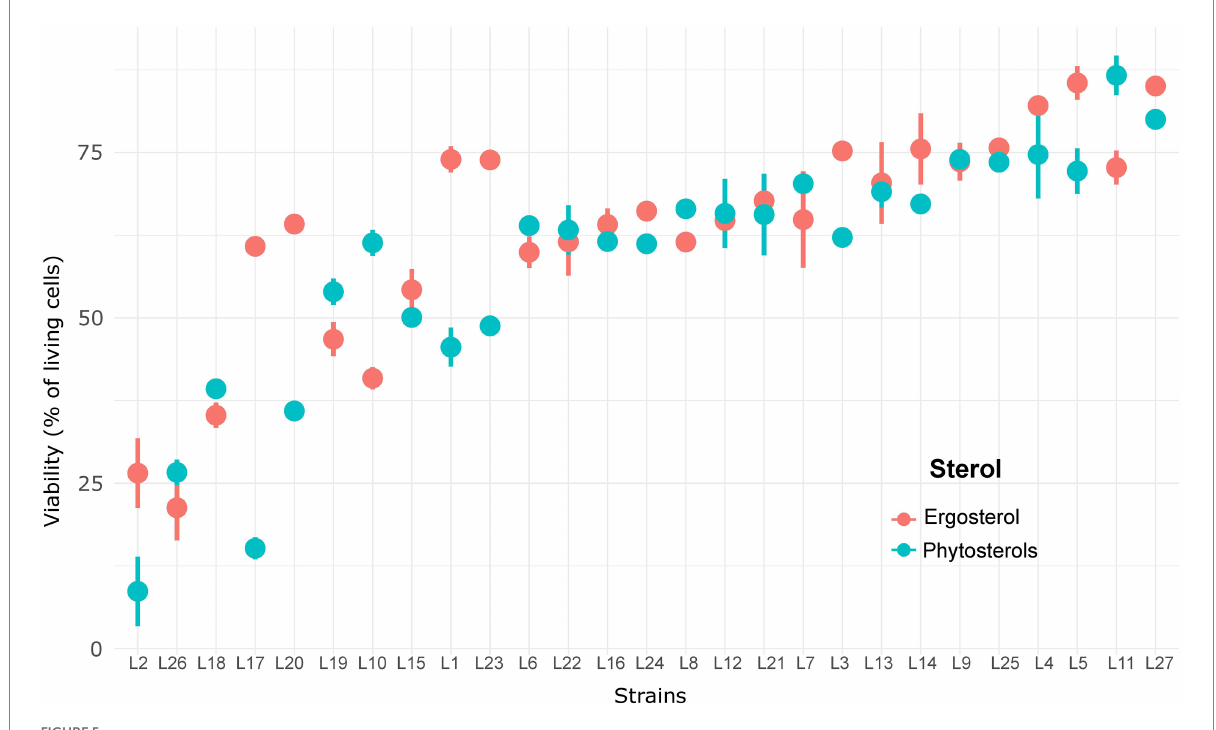
FIGURE 5 Viability of 27 Saccharomyces cerevisiae strains under high sugar content with ergosterol and phytosterols.